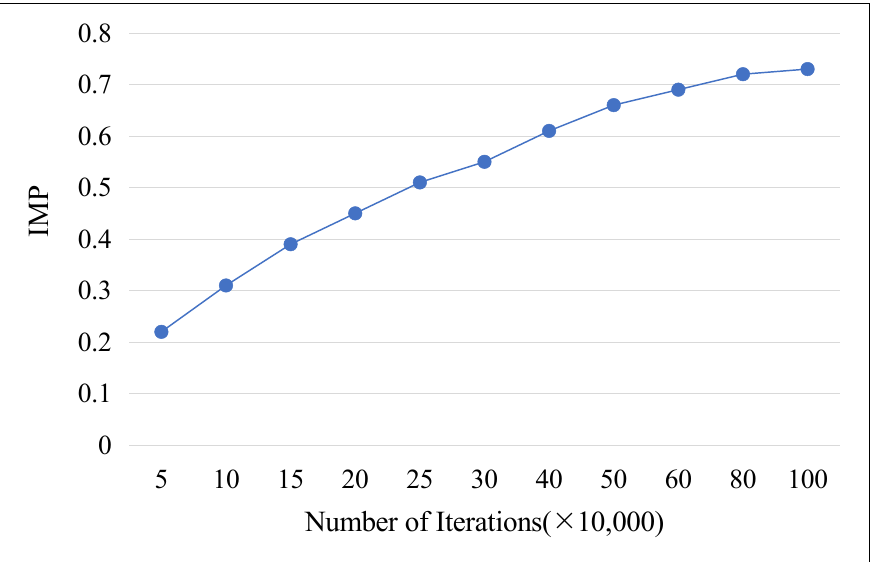
Figure 14. Average IMP in duplicate bridge